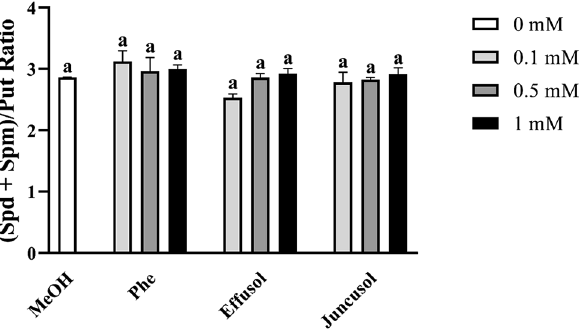
Figure 14. Ratio of (Spd + Spm)/Put of seedlings treated with Phe, effusol and juncusol at different concentrations compared to MeOH. Data are presented as the mean ± SE (n = 3). Different letters indicate significant differences between the values of the treatments (P < 0.05) analysed by Tukey’s post-hoc